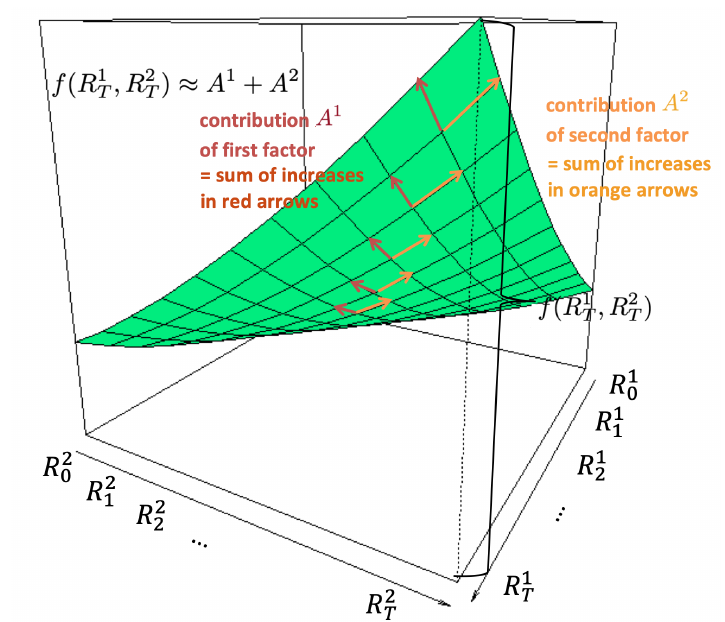
Figure 2. Rather than computing the linear contribution for the two factors from zero, our method uses a step-wise procedure: we consider the contributions for each of the two factors along a trajectory ) . We approximate f ( R 1 to the value f ( R 1 , R 2 T T consist of the sums of the increases in the red and orange arrows, respectively. This procedure leads to a much more accurate linear approximation of f ( R 1 ) from the initial time to time T . and f ( R 1 , R 2 T 0